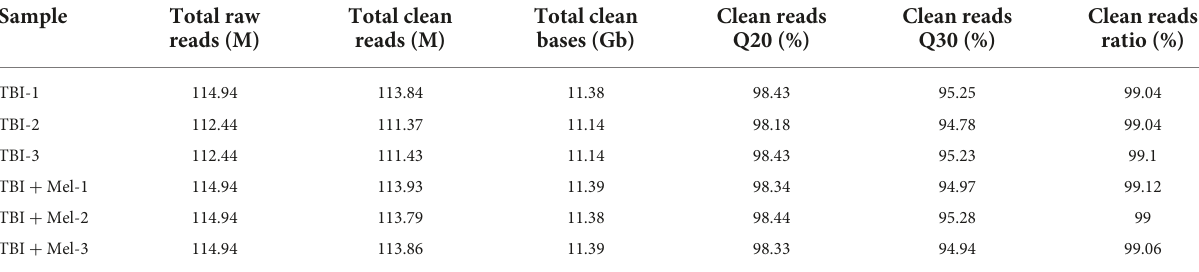
TABLE 2 Information of quality control of RNA